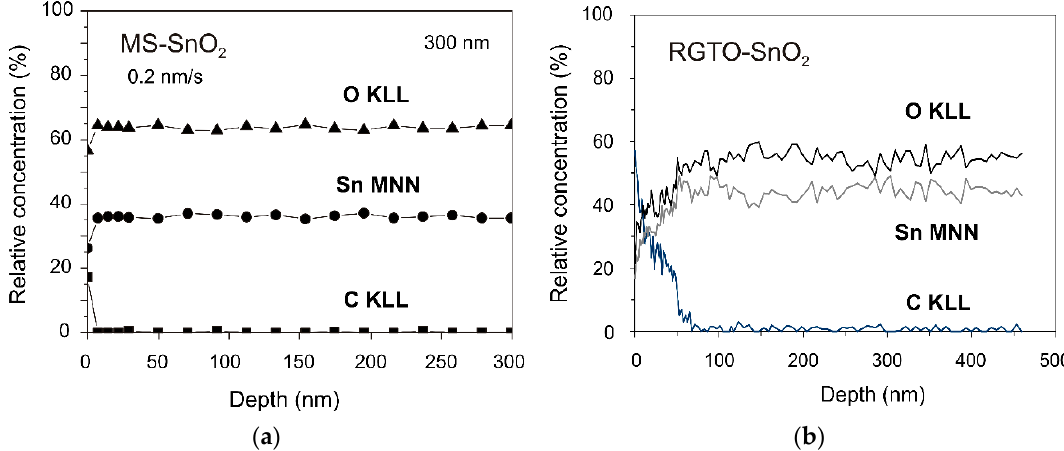
Figure 8. Composition depth profiles of the relative element concentration in the near-surface region and the bulk of the SnO 2 layer formed by ( a ) magnetron sputtering and ( b ) RGTO methods.